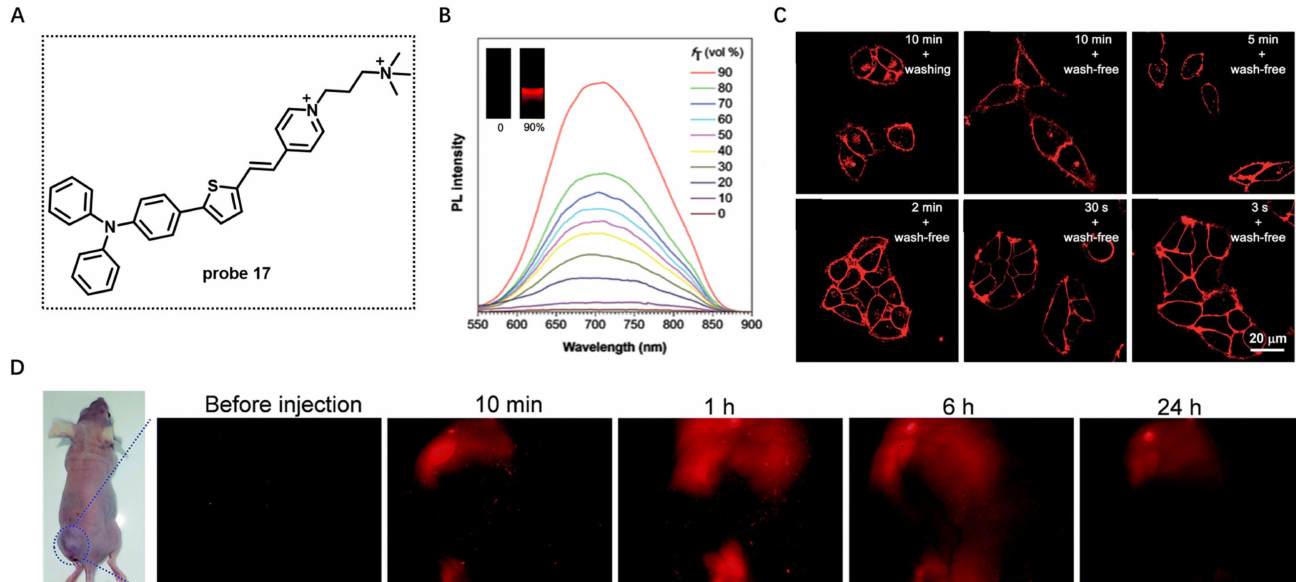
Figure 17. ( A ) Chemical structure of probe 17 . ( B ) PL spectra of probe 17 in water/THF mixtures with different THF fractions. ( C ) Confocal images of living HeLa cells with probe 17 by the use of a washing or wash-free procedure. Scale bar: 20 µ m. ( D ) In vivo imaging using probe 17 . Copyright 2018 Royal Society of Chemistry